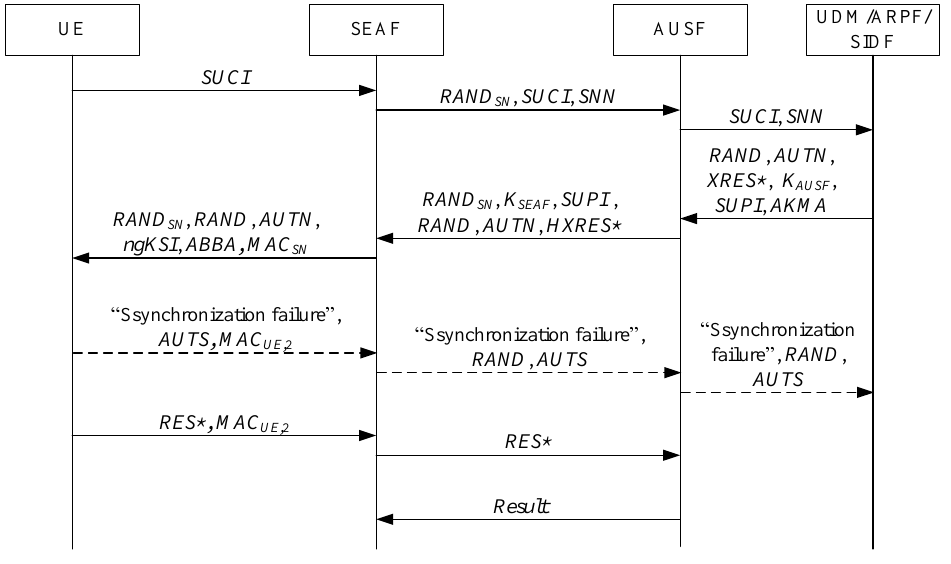
Figure 2. Our proposed 5G-IPAKA protocol.